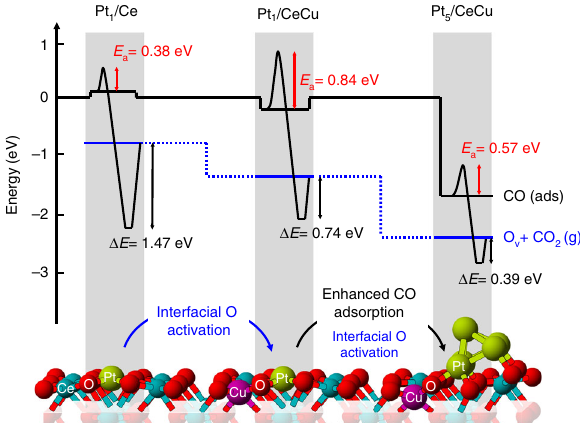
Fig. 4 Oxidation energetics of adsorbed CO molecules by interfacial oxygens of Pt 1 /Ce, Pt 1 /CeCu and Pt 5 /CeCu. Source data are provided as a Source Data fi